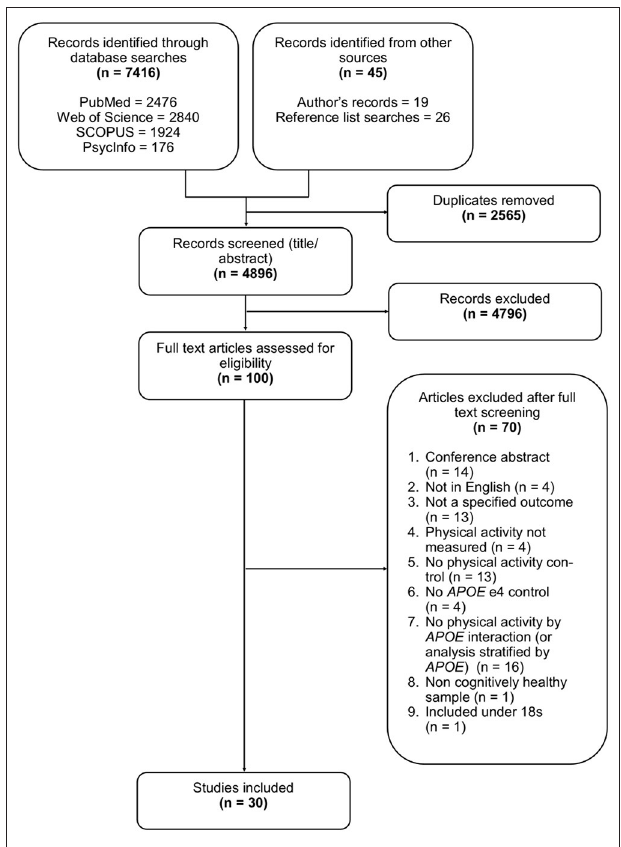
FIGURE 1 | Flow diagram detailing the selection process for study inclusion.